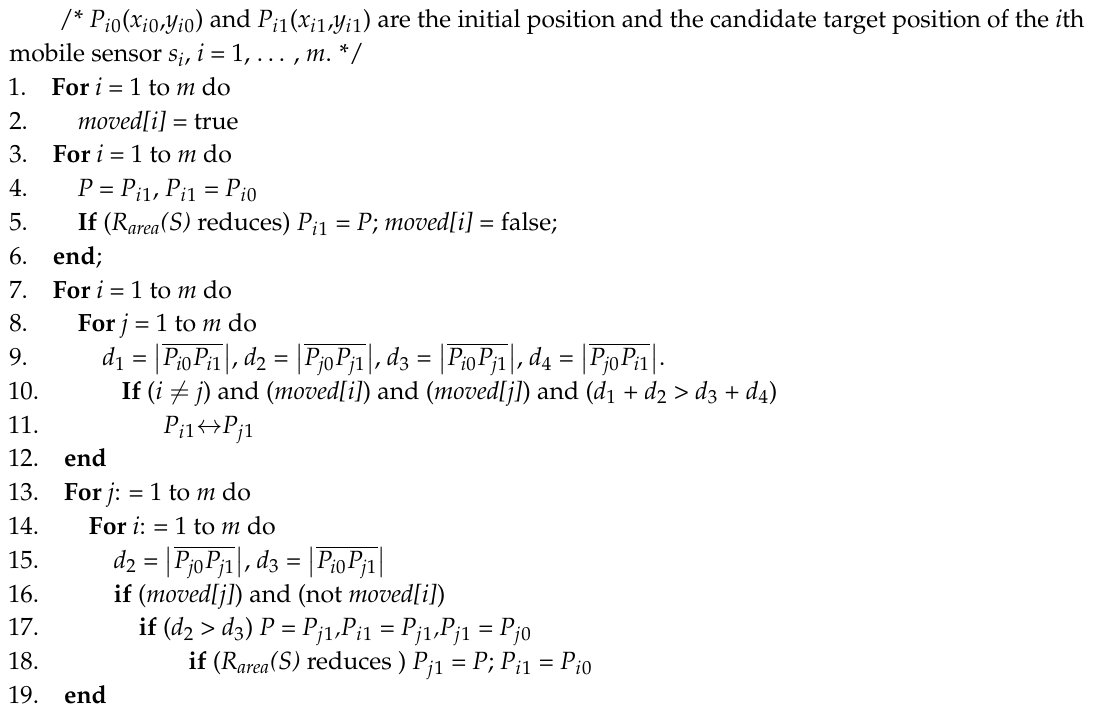
Algorithm 1. Pseudocode for the moving distance reduction